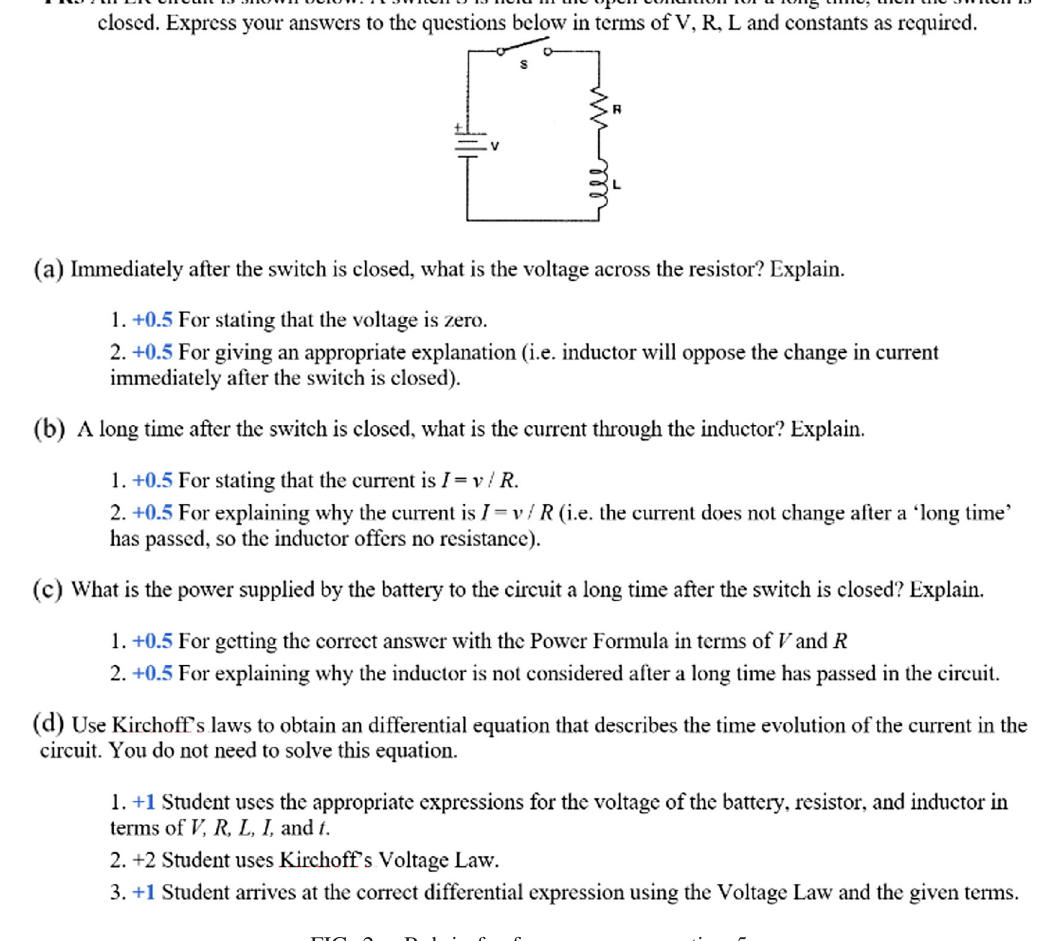
FIG. 2. Rubric for free response question 5.